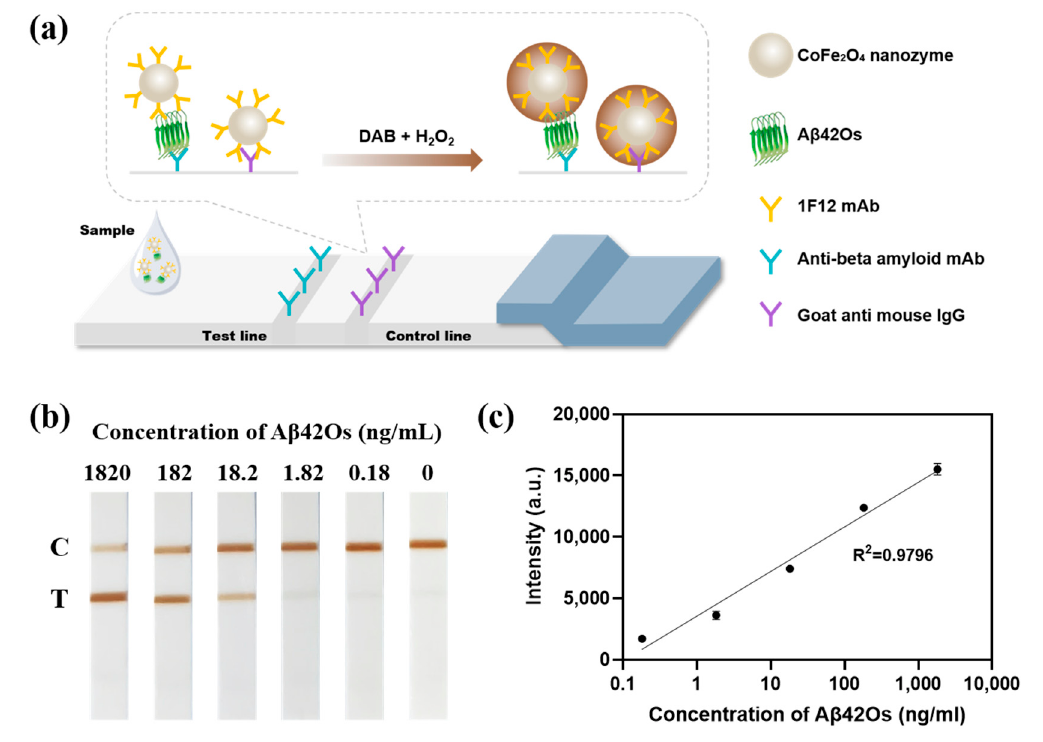
Figure 7. A β 42Os detection by nanozyme-strip based on CoFe 2 O 4 -1 nanozyme probe. ( a ) Illustration of nanozyme-strip for A β 42Os detection. ( b ) Detection of A β 42Os with CoFe 2 O 4 -1 nanozyme-strip. ( c ) Relative analysis of signal intensity regarding T lines.